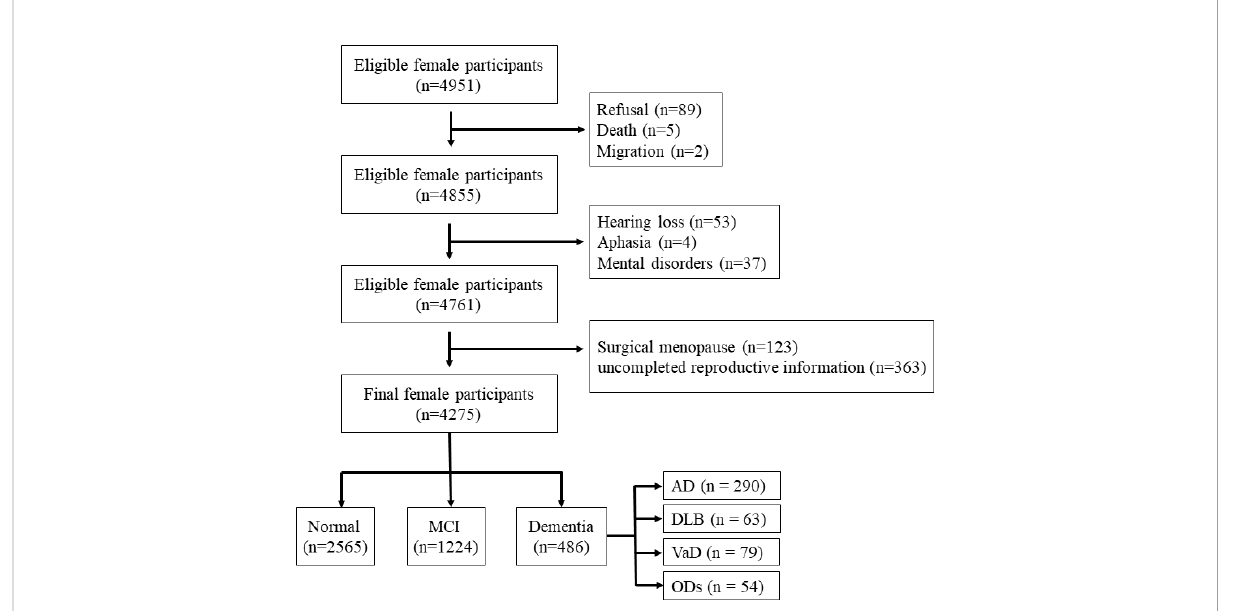
FIGURE 1 Flowchart of this study. MCI, mild cognitive impairment; AD, Alzheimer ’ s disease; DLB, dementia with Lewy bodies; VaD, vascular dementia; ODs, other